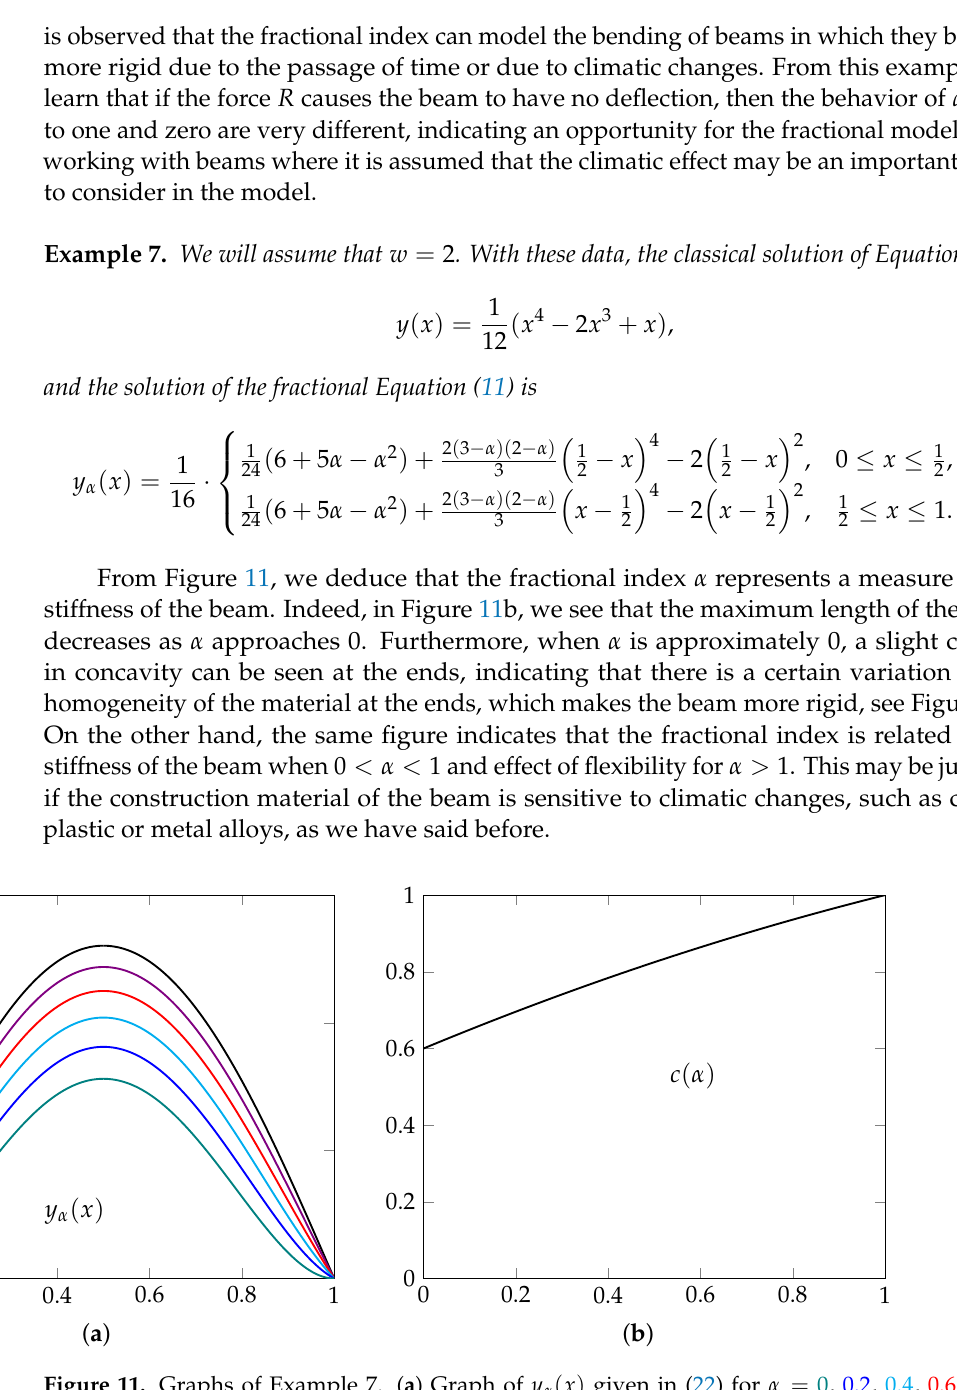
Figure 11. Graphs of Example 7. ( a ) Graph of y α ( x ) given in (22) for α = 0, 0.2, 0.4, 0.6, 0.8, 1. ( b ) Graph of c ( α ) given in